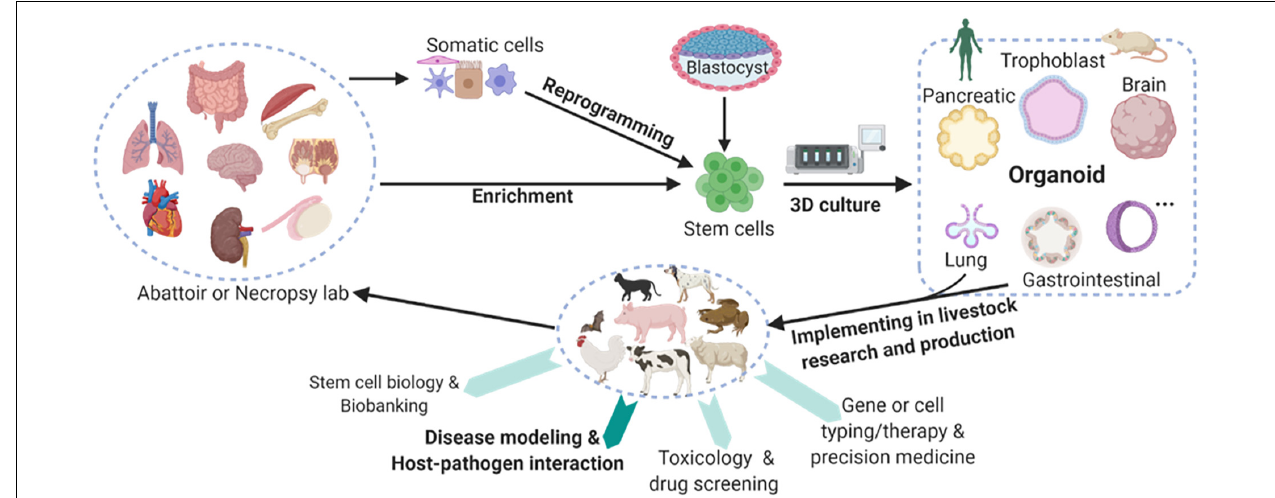
FIGURE 1 | Schematic of mainstream organoid culture in humans and mice and their multifaceted potential in the promotion of domestic and wild animals studies. Organoids, also known as “mini-organs,” are three-dimensional (3D) constructs that differentiate from stem cells to recapitulate cellular architecture and functionality of native organs. Multiple types of organoids have been cultured primarily in humans and mice, and they have profoundly revolutionized the research and practice in human medicine. Some types of organoid culture have also been validated in livestock species. However, these cultures must be extended for promoting research and production in agricultural animals. Collectively, organoid research in domestic animals will provide dual roles and dual benefits in promoting the wellbeing of both the animals and humans with several advantages. These advantages include reliable offal resources, easier handling regarding organ size when compared to that of a mouse, and more physiological similarity in modeling human organs. Animal organoid studies will reveal unknown species-specific prospects in terms of organ development, stem cell biology, mechanistic regulation at gene and cellular levels, and particularly disease modeling and host-pathogen interaction for epizootic and zoonotic viral infections. Created with